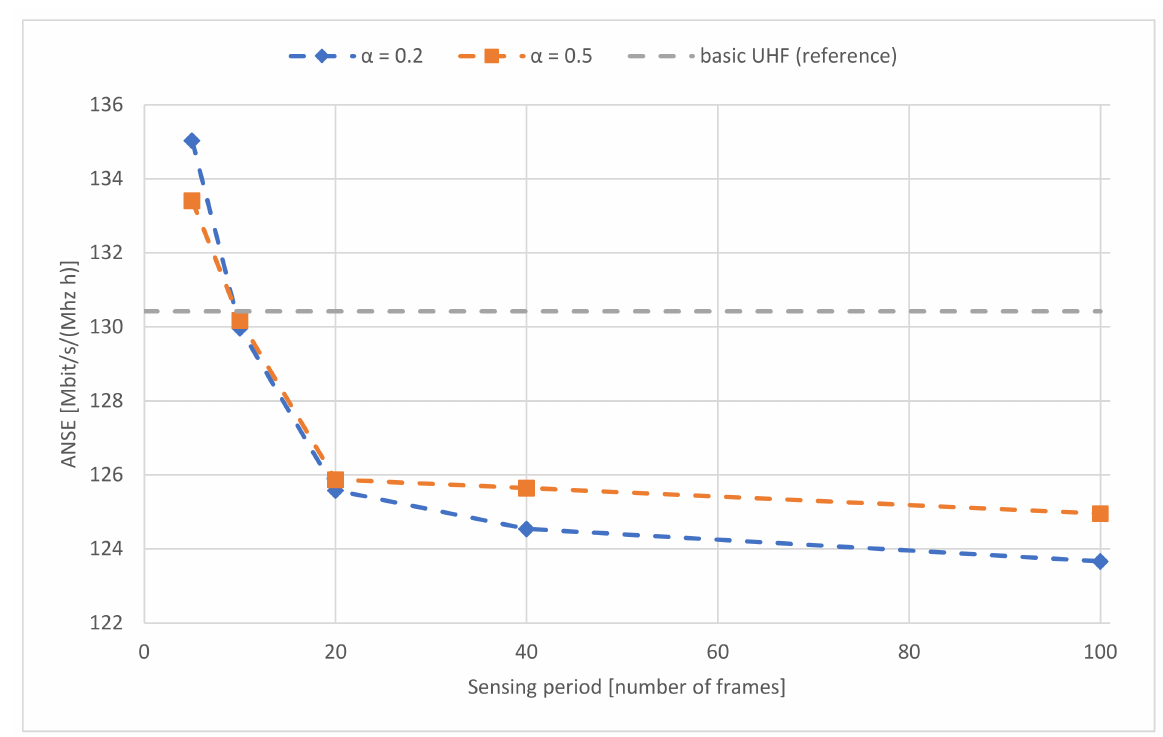
Figure 16. Average Network Spectrum Efficiency vs. different sensing periods for scenario